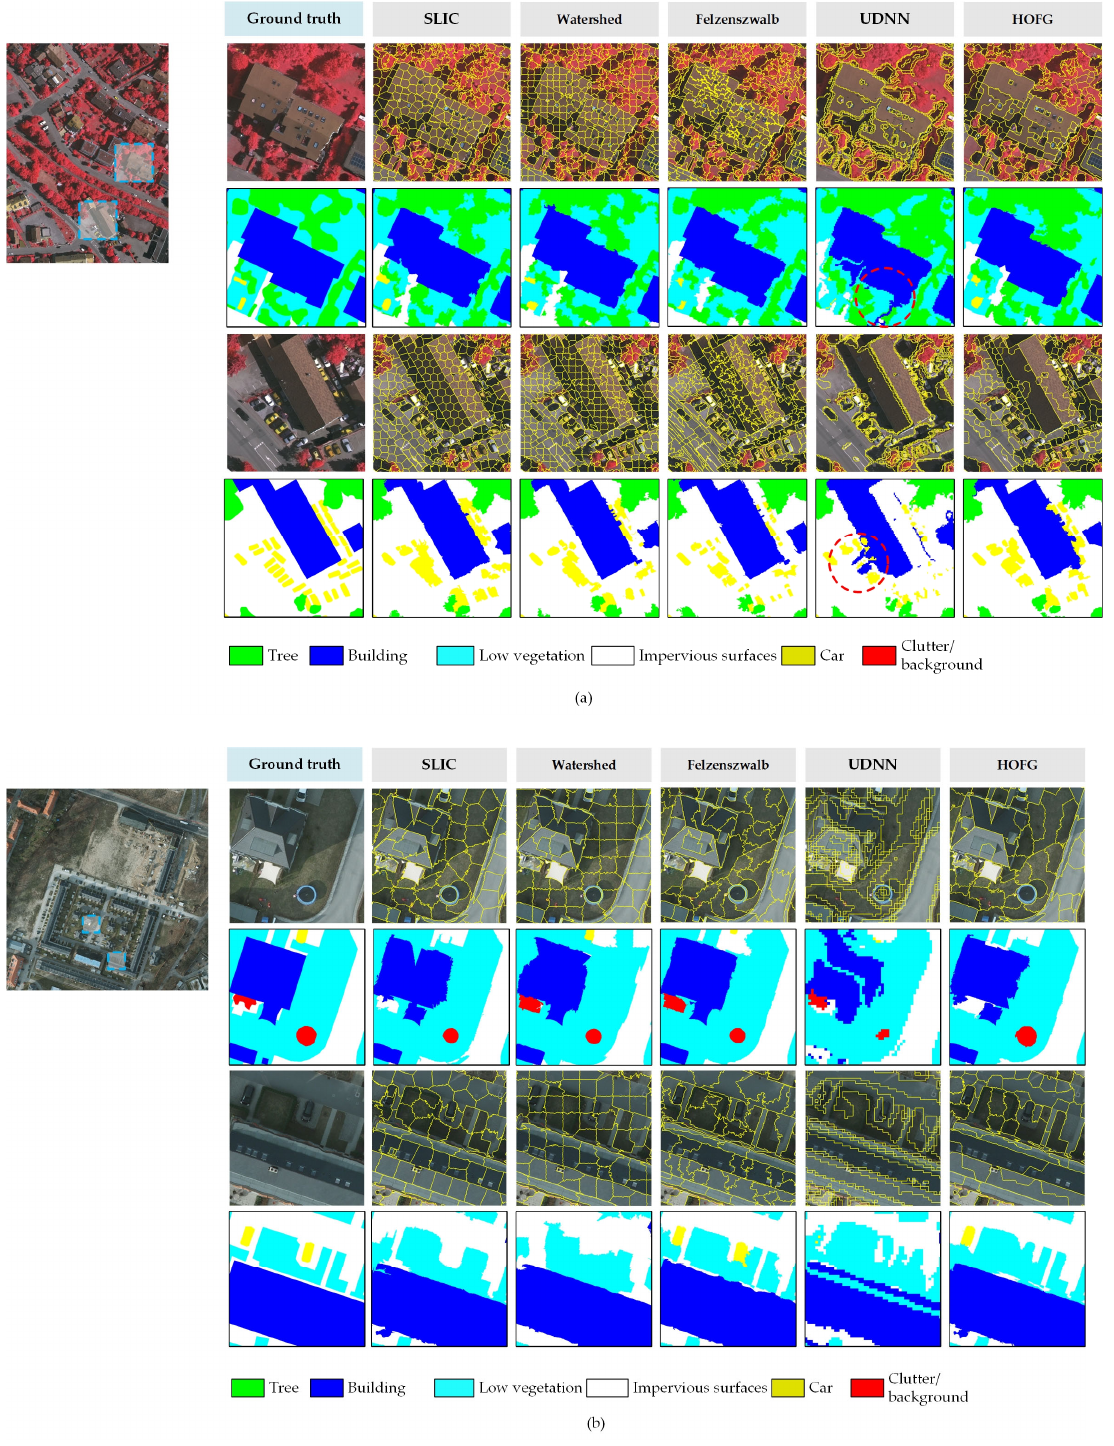
Figure 10. Detailed comparisons of the five methods on test images 1 and 2: ( a ) segmentation results for test image 1; ( b ) segmentation results for test image